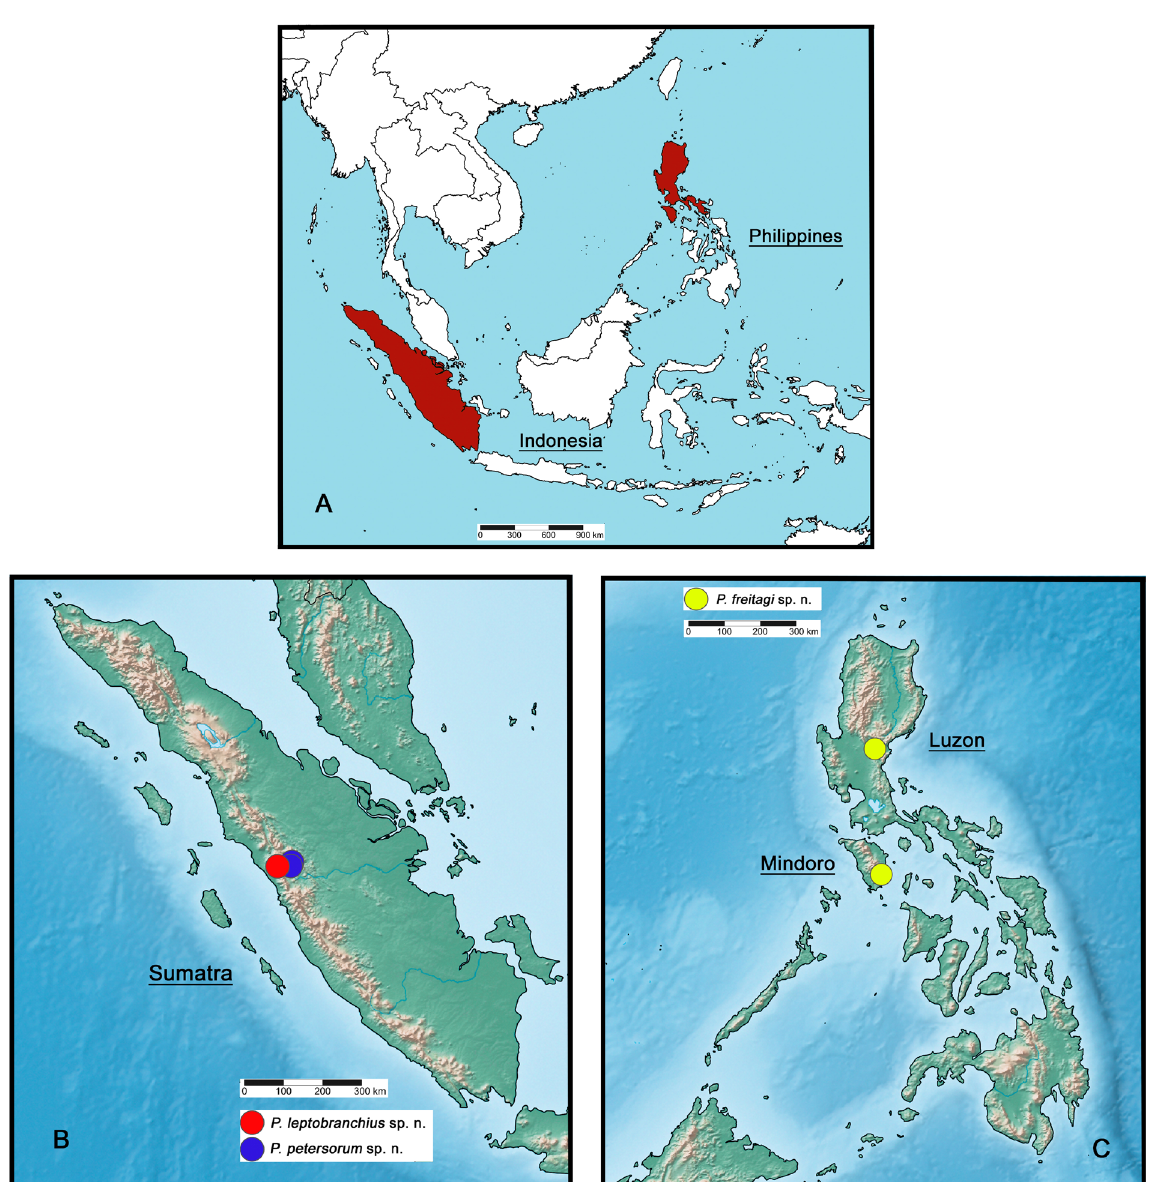
Fig. 14. Distribution of Procerobaetis gen. nov. A . Map of Southeast Asia. B . Localities in Indonesia. C . Localities in the